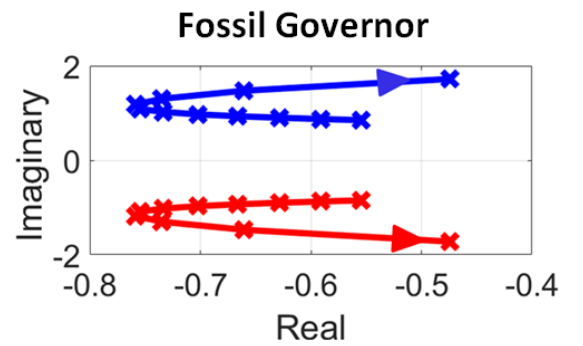
Figure 4. Impact of H on closed loop poles for Fossil Governor.